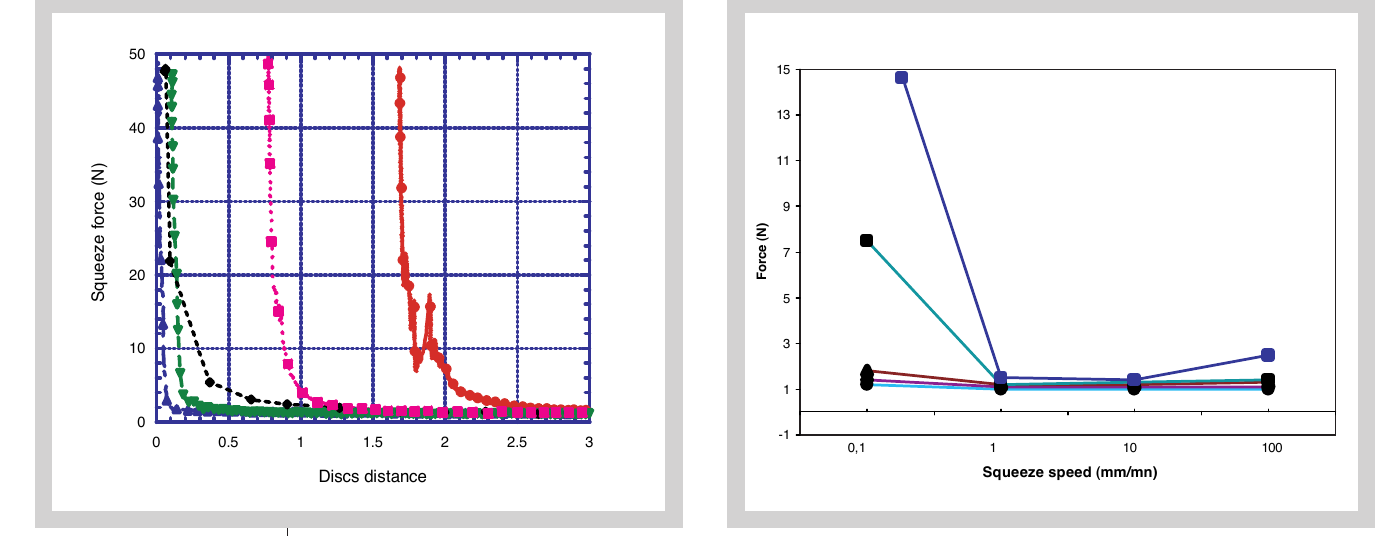
Figure 5 (left): Evolution of the squeeze force F as a function of discs separation h for different disc velocities U, for a SCC paste: Ï 100 mm/mn; Ê 10 mm/mn; Ú 1 mm/mn; Á 0.3 mm/mn; · 0.1 mm/mn. Figure 6: Evolution of the squeeze force as a function of speed for different instantaneous discs separations h for the case of a SCC paste: · 5.4mm; Û 5.16 mm; Ì 5 mm; Á 4 mm; Ê 3 mm; ‡ 2 mm; Ú 1